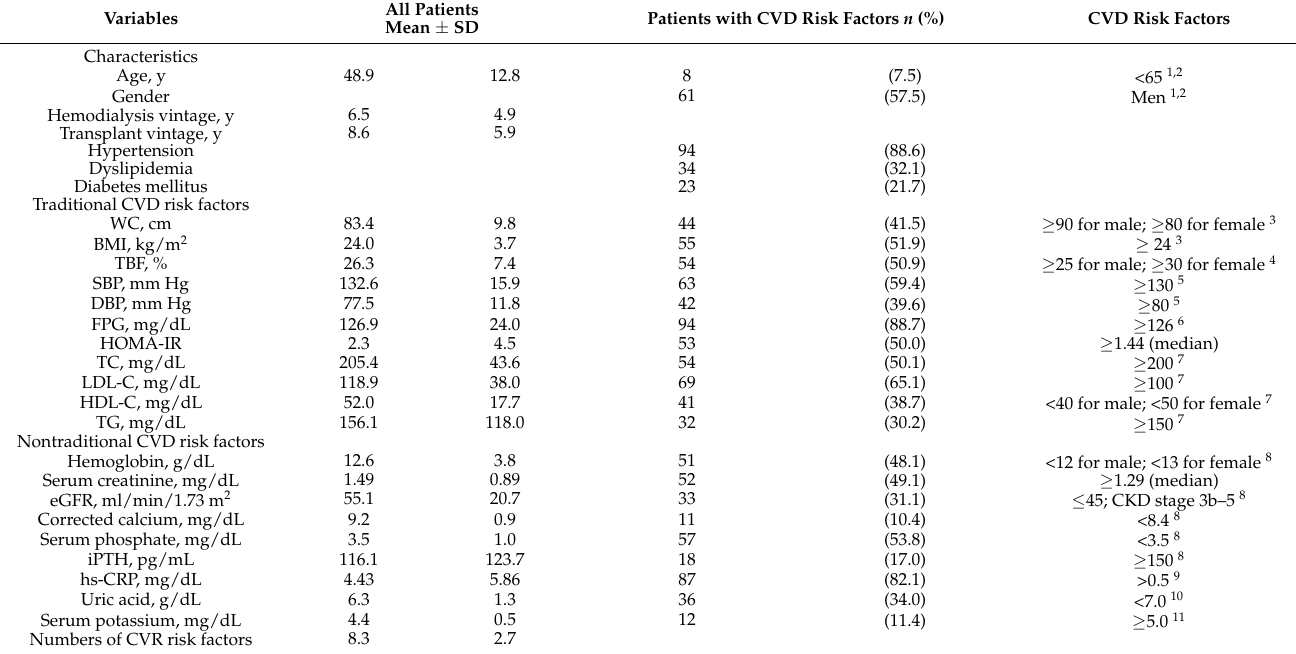
Table 1. Characteristics and cardiovascular risk factors in renal transplant recipients ( n =